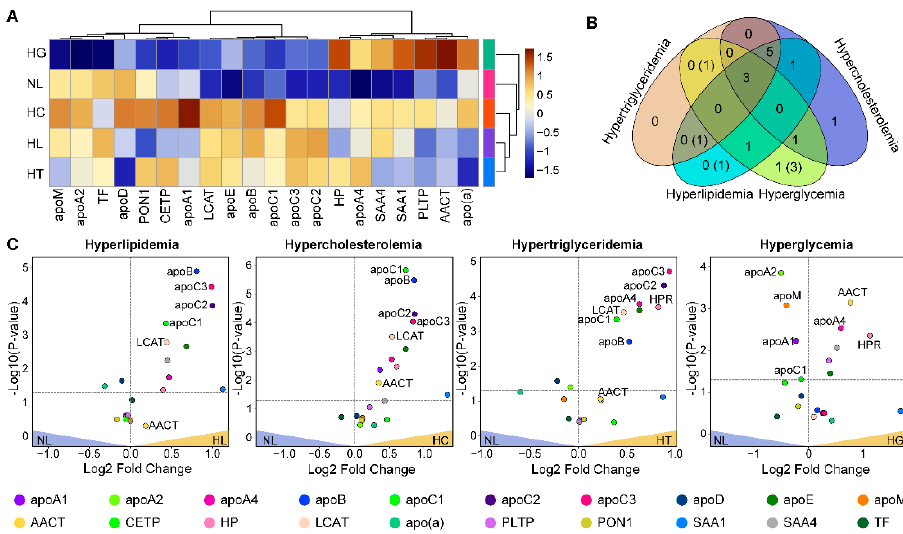
Figure 3. Dysregulated proteins in metabolic groups. ( A ) Heat map comparison and clustering of protein concentrations for hyperlipidemia (HL), hypercholesterolemia (HC), hypertriglyceridemia (HT), hyperglycemia (HG), and normolipidemic (NL) samples. The proteins and sample groups are shown in rows and columns, respectively. The colors correspond to the Z-score normalized by the grand mean of each protein concentration. ( B ) Volcano plots show individual protein concentrations that were dysregulated relative to normal (NL) samples. The horizontal line on the plots shows a p - value ≤ 0.05. ( C ) The Venn diagram summarizes the number of proteins significantly upregulated in different metabolic groups, the numbers in parentheses are for down-regulated proteins. Table 2. Comparison of protein concentrations for the metabolic groups. Average of measured pro- tein concentrations (min/max). One-way ANOVA test was used to determine statistically significant differences between sample groups ( p -value <0.05 was considered significant). Protein